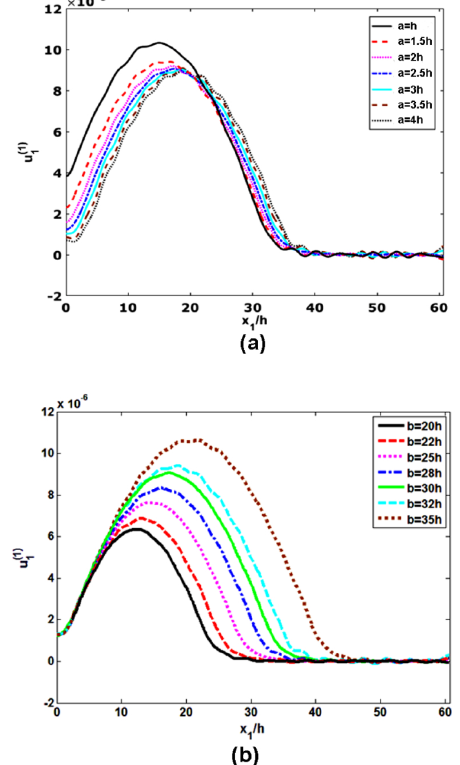
( 1 )   1 u : ( a ) electrode gap a ; ( b ) : ( a ) electrode gap a ; 1 1